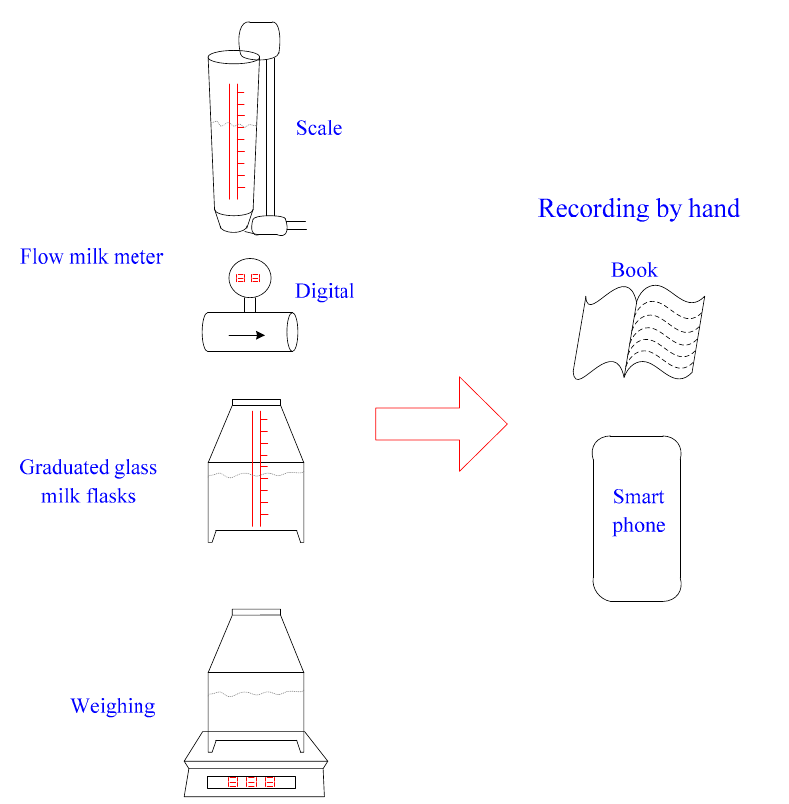
Figure 2. Milk quantity recording system by hand.